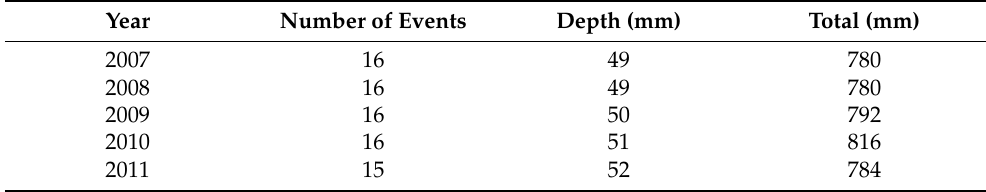
Table 4. Irrigation depths and events during the E1 seasons.